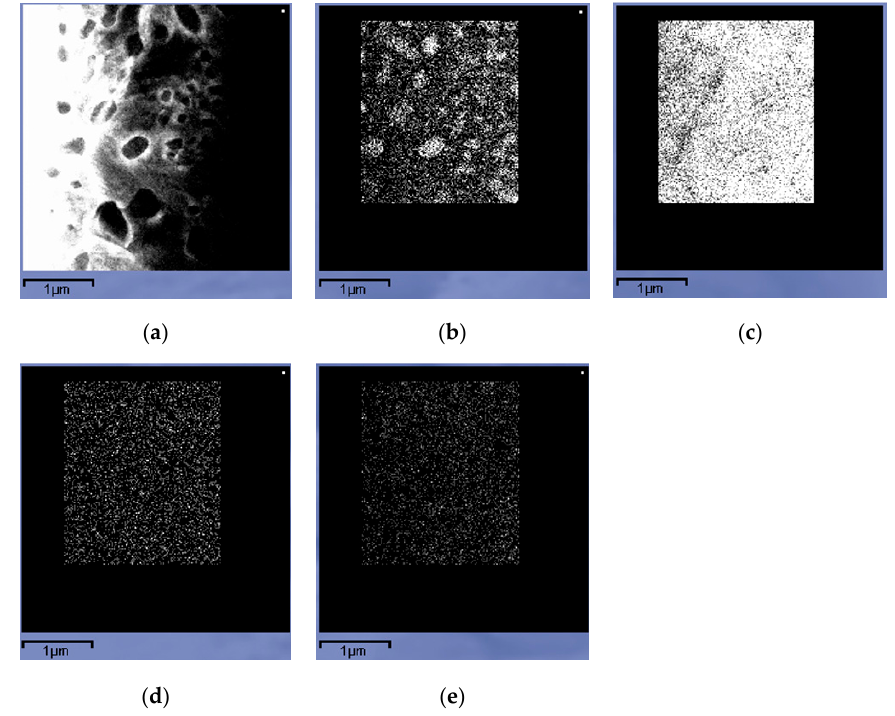
Figure 9. ( a ) STEM image of HT sample; The elemental distribution of ( b ) Cr; ( c ) Fe; ( d ) C and ( e ) Mn.